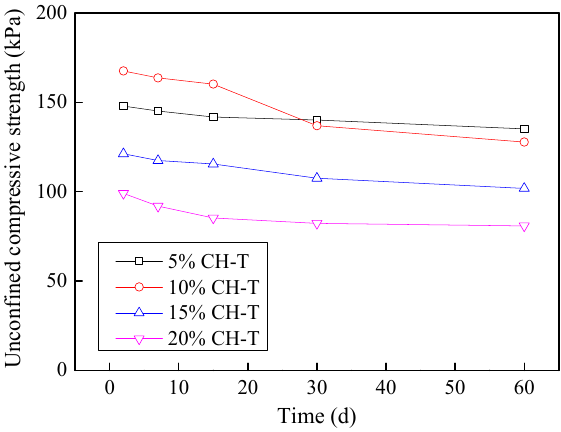
Figure 17. Effects of tannery effluent on the cohesion of CH soil samples.